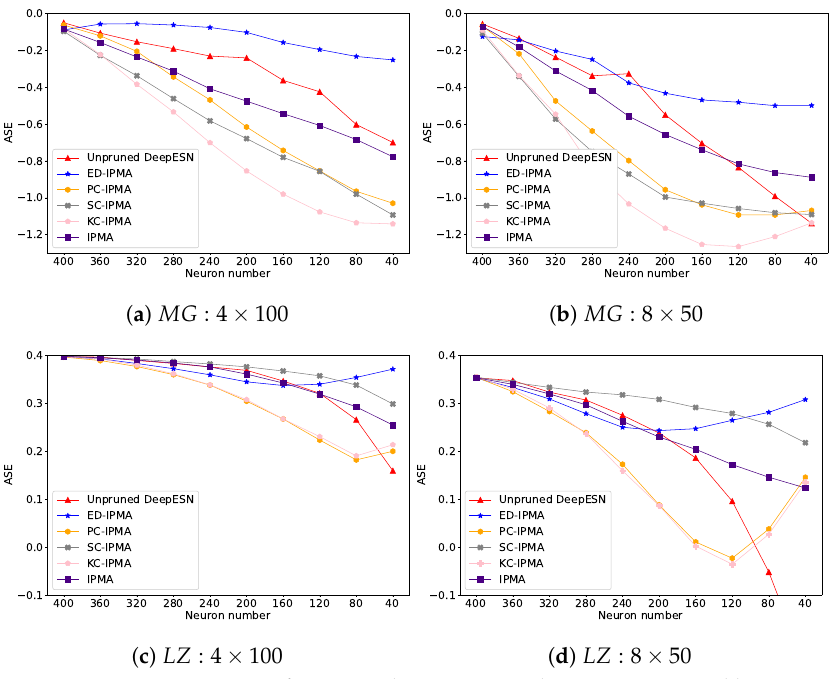
Figure 8. ASE comparison of unpruned DeepESN and DeepESN pruned by IPMA, ED-IPMA, PC- IPMA, SC-IPMA, KC-IPMA. ( a ): Initial 4 layer reservoirs with 100 neurons in each reservoir on MG dataset; ( b ): Initial 8 layer reservoirs with 50 neurons in each reservoir on MG dataset; ( c ): Initial 4 layer reservoirs with 100 neurons in each reservoir on LZ dataset; ( d ): Initial 8 layer reservoirs with 50 neurons in each reservoir on LZ dataset.